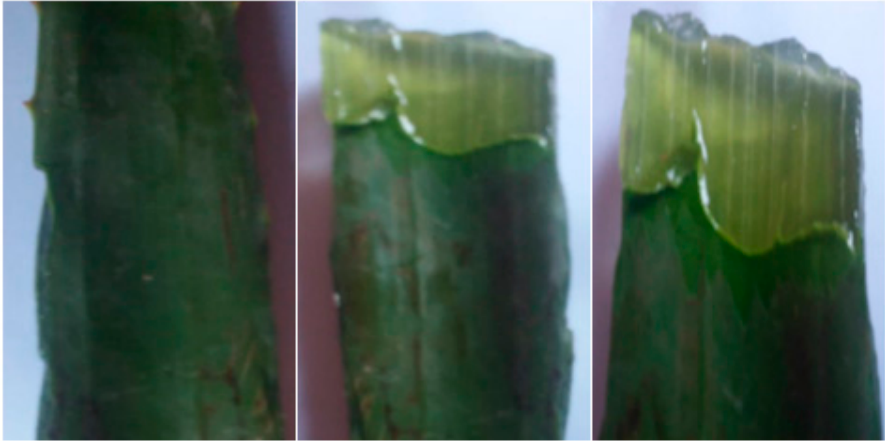
Figure 1. A. vera leaf showing outer green rind and viscous clear liquid (gel). Based on HPLC analysis, different flavonoids and phenolic acids were detected in the extract of A. vera gel with different concentrations and retention time (Table 1 and Figure echin with the concentrations o f 1637.09, 1552.92, and 1100.43 µg/mL, respectively. Other